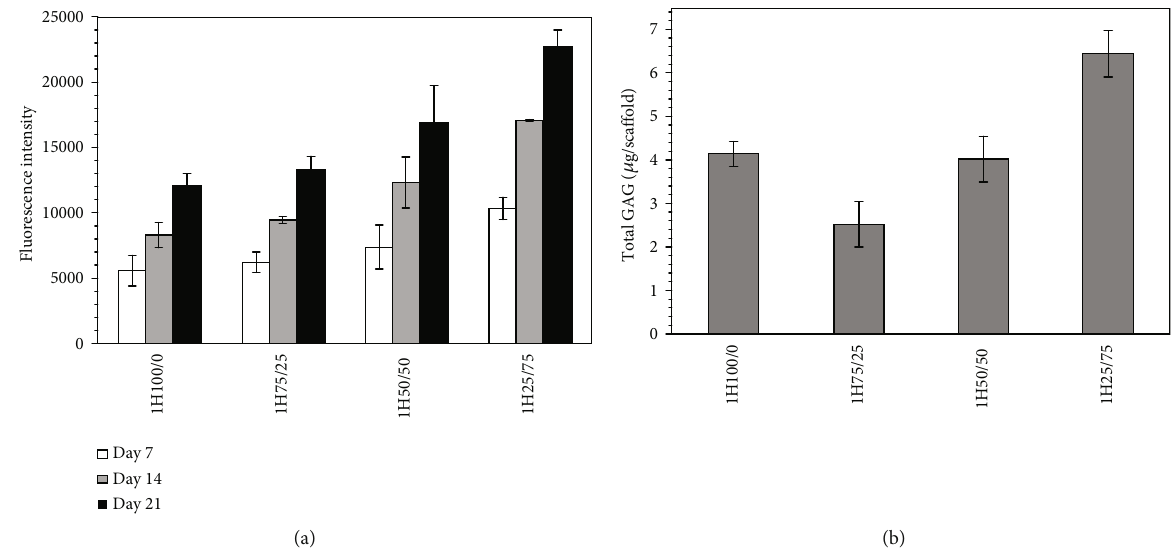
Figure 6: (a) Proliferation of porcine chondrocytes at 7, 14, and 21 days of culture and (b) amounts of extracted glycosaminoglycans after cultured for 21 days on the surface-modi fi ed sca ff olds with NaOH at di ff erent blending